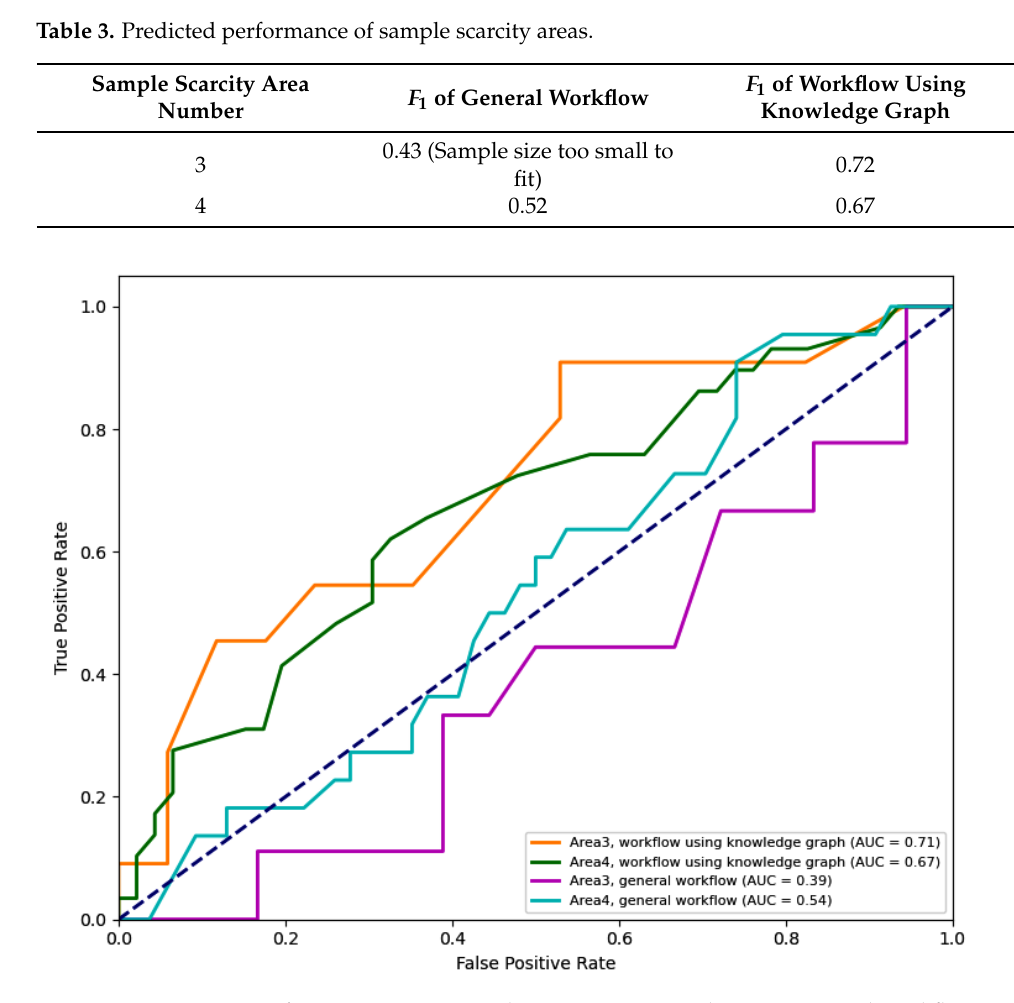
Figure 10. Comparison of Receiver Operating Characteristic Curves between General Workflow and Workflow Using Knowledge Graph in Area 3 and Area